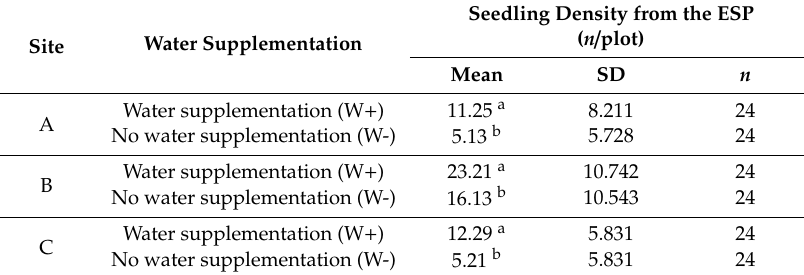
Table 9. Mean density of P. brutia seedlings which survived from the ESP (December 2009) in the plots in which water supplementation was applied and, in the plots, where no watering took place (averaged over the two levels of the factor ‘sowing environment’) in each of the three sites (‘water supplementation’ main